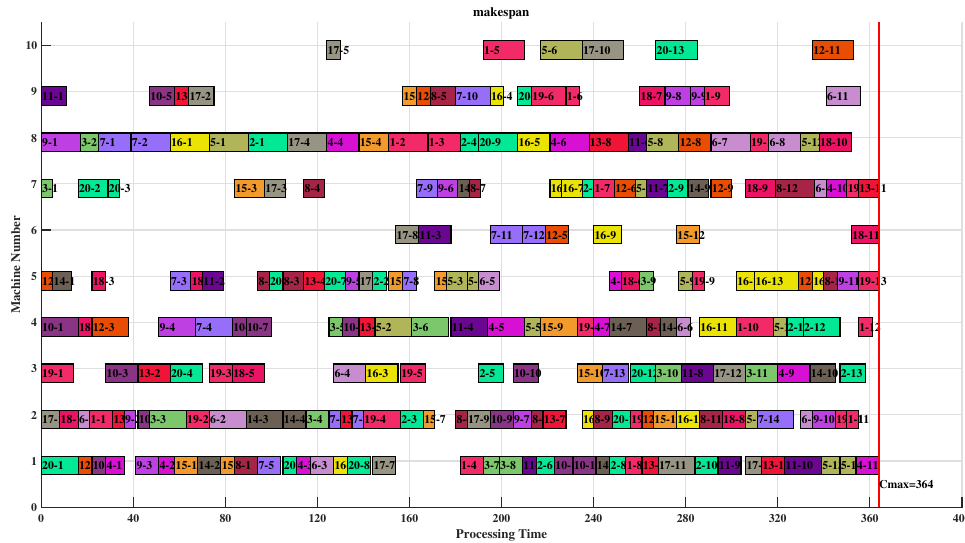
Figure 17. The scheduling scheme of Brandimarte MK9 (20 × 10). Table 9. The RPD (%) obtained by 11 algorithms to solve 10 instances.